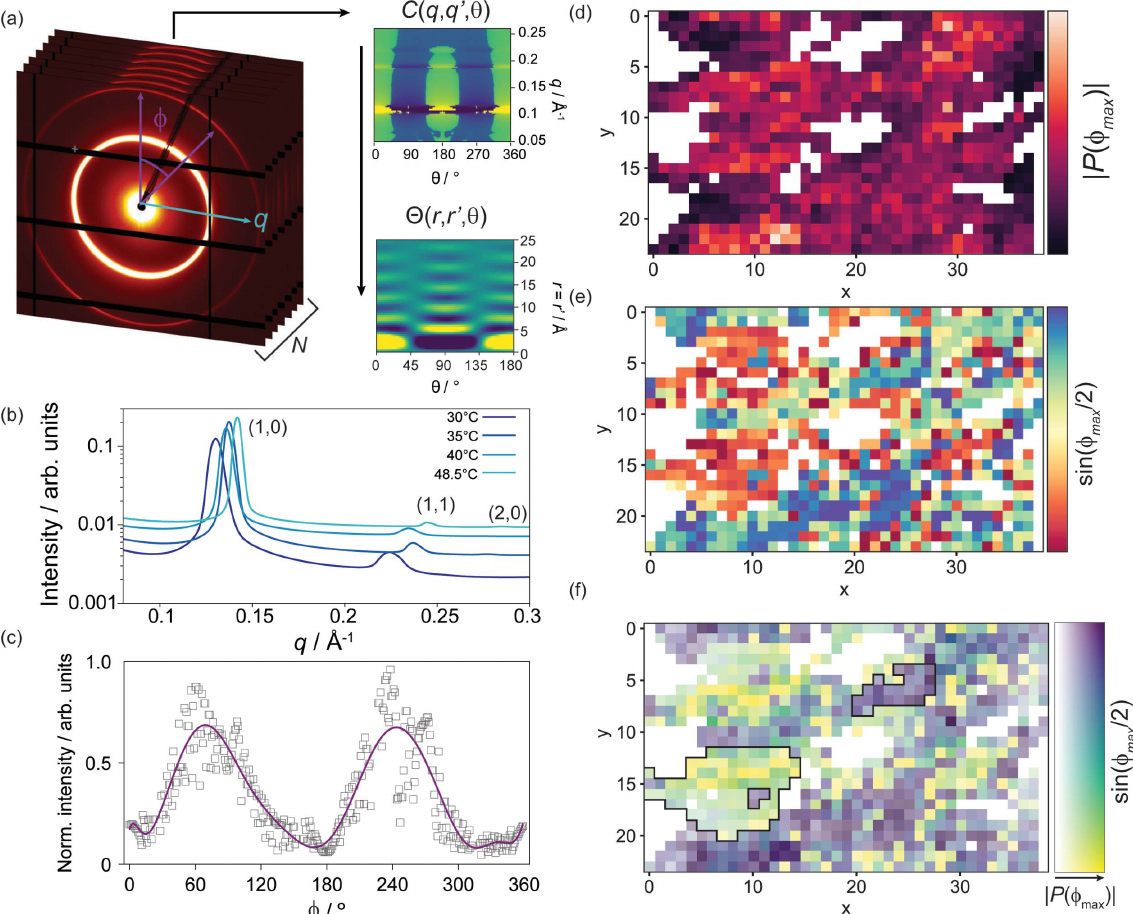
Figure 2 ( a ) From an ensemble of SAXS patterns, a three-dimensional q -space intensity-correlation function is generated. This correlation function is transformed into a three-dimensional real-space PADF. In this ensemble, we show a representative SAXS pattern from the hexagonal phase of CTAB– H 2 O. Intensity modulations around the ring (as a function of (cid:2) ) are weak and the smooth rings indicate the presence of many domains within the beam. ( b ) Standard SAXS patterns confirm the hexagonal mesophase structure. ( c ) Close inspection reveals a preferred-orientation effect with characteristic twofold angular peaks. Determination of the ( d ) magnitude [ P ( (cid:2) max )] and ( e ) angle ( (cid:2) max ) of the orientation combined to ( f ) indicate the presence of macroscopic domains with shared orientations. White pixels indicate data points omitted during the filtering stage. Black lines illustrate examples of domains in this